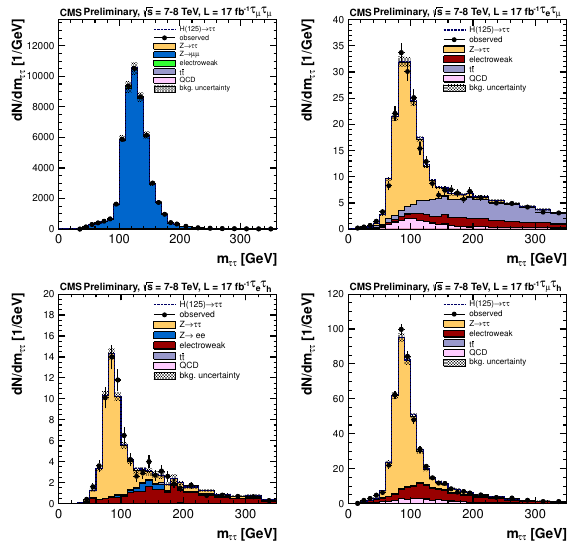
Figure 2. Fully reconstructed invariant mass of the di- τ system in the 2-Jet (VBF) event category. Shown are invariant mass dis- tributions of the (upper left) µµ , (upper right) e µ , (lower left) e τ h , and (lower right) µτ h decay channel. The fully reconstructed in- variant mass of the di- τ system in the 2-Jet (VBF) event category in the τ h τ h decay channel is shown in figure 3 (right).